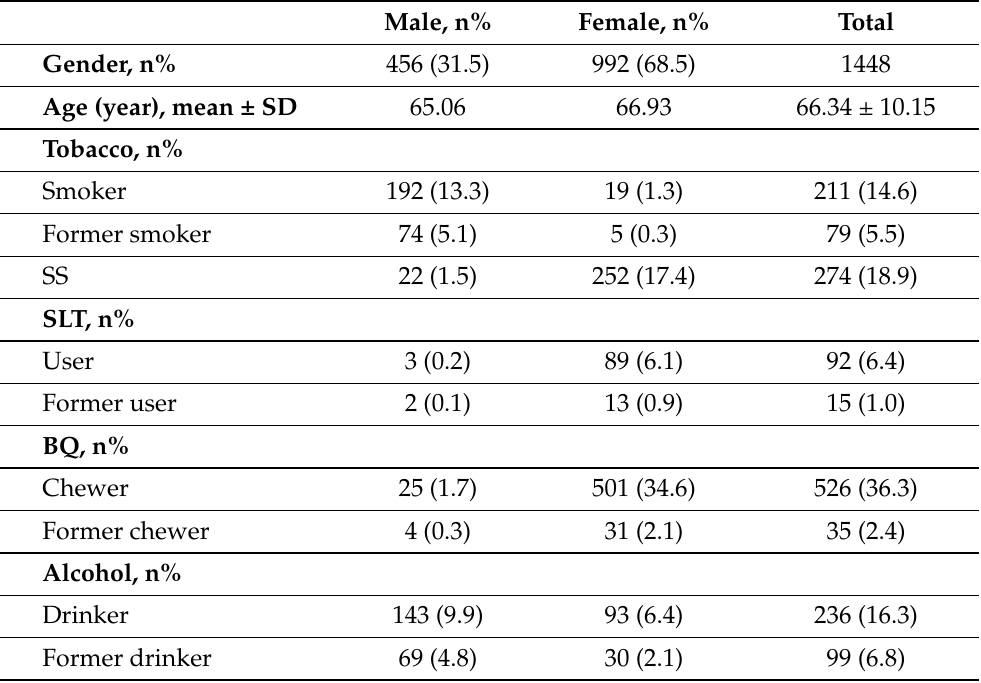
Table 1. Demographic and quantitative data analysis.